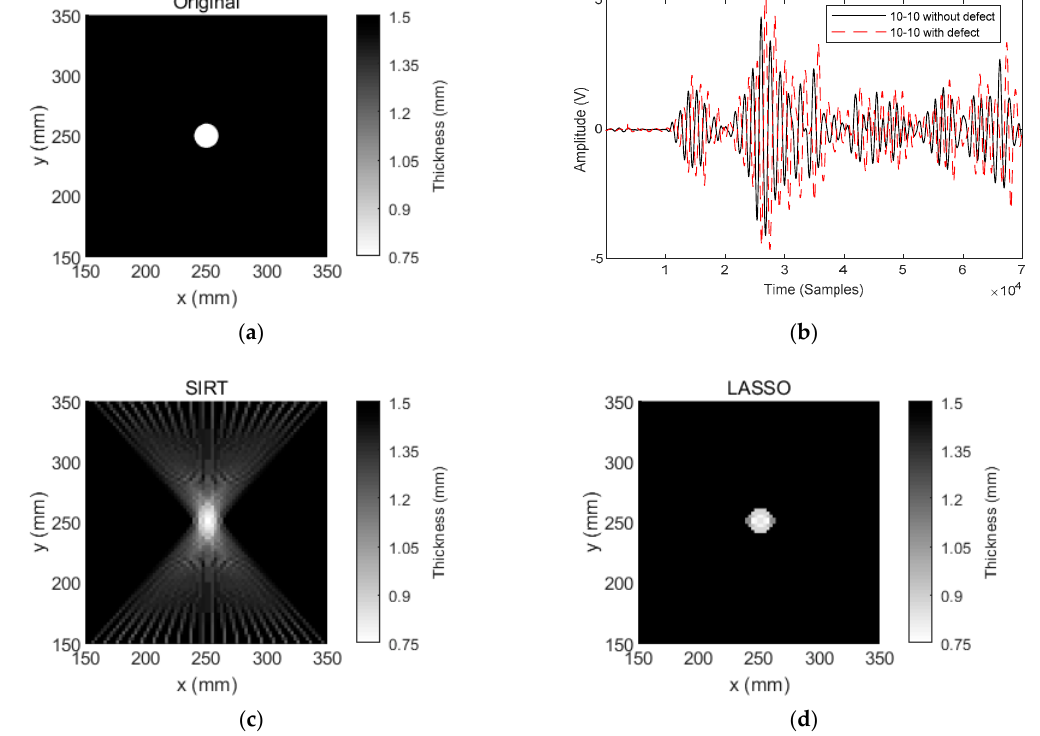
Figure 5. Tomographic reconstruction images for a 1.5 mm thick aluminum plate with a 20 mm diameter circular flat-bottomed hole. Thickness loss was 50% within the flaw. ( a ) The actual location and size of the flaw, ( b ) the baseline guided wave signal and the guided wave signal passing through the defect, ( c ) the tomographic reconstruction image using the simultaneous iterative reconstruction technique (SIRT), and ( d ) the tomographic reconstruction image using our method.